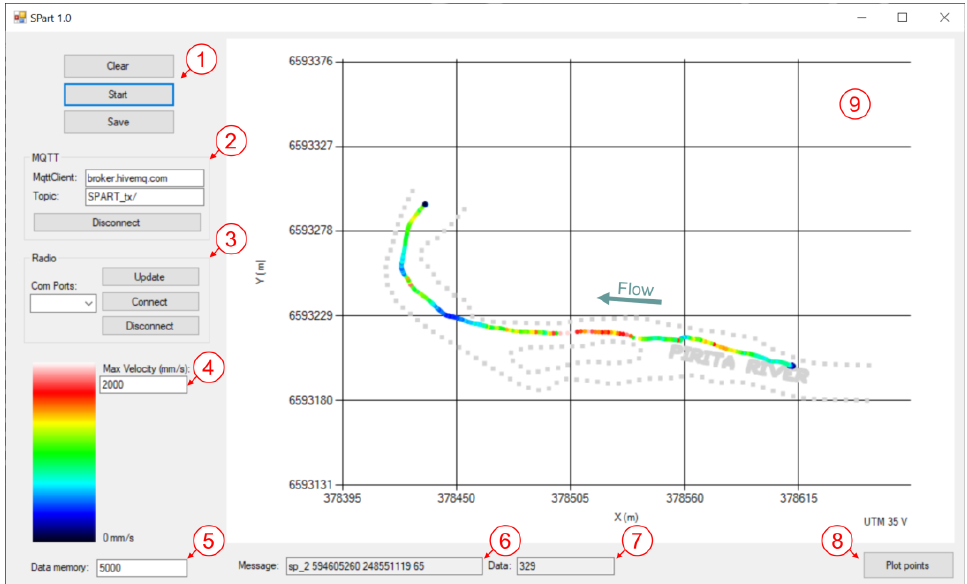
Figure 3. SPart software for drifter tracking with different communication alternatives. The figure shows the track of a drifter with mobile communication in the studied reach. (1) Main control menu. (2) Connection to MQTT broker. (3) Connection to Radio Gateway. (4) Velocity scale definition. (5) Number of positions on the screen. (6) Latest drifter message received. (7) The total number of messages received. (8) Load a set of reference points (gray point background). (9) Map with the received data and positions (automatically converts data from WGS84 geographical coordinates to UTM format for representation).